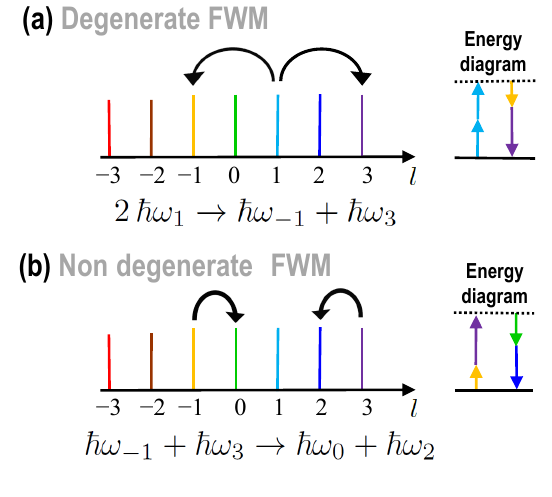
Figure 2: (Color online) Schematic representation of FWM in the frequency domain. In a given family, the eigenmodes of the res- onators are quasi-equidistantly spaced as ω ℓ ≃ ℓ Ω FSR , so that they are unambiguously labeled by their azimuthal eigenumber ℓ . It is convenient to use instead the reduced eigenumber l = ℓ − ℓ 0 , with ℓ 0 being the central (pumped) mode. (a) Degenerate FWM. Two photons from one mode (not necessarily the pumped mode l = 0 ) are symmetrically up and down converted, following the interaction 2 (cid:126) ω (cid:126) ω + (cid:126) ω 2 m = n + q . The reverse interaction m → n q , with (cid:126) ω + (cid:126) ω 2 (cid:126) ω n q → m is degenerate as well. (b) Non-degenerate FWM. Two photons with eigenumbers m and p are converted into two output photons n and q through (cid:126) ω m + (cid:126) ω p → (cid:126) ω n + (cid:126) ω q where m + p = n + q , with the four photons being